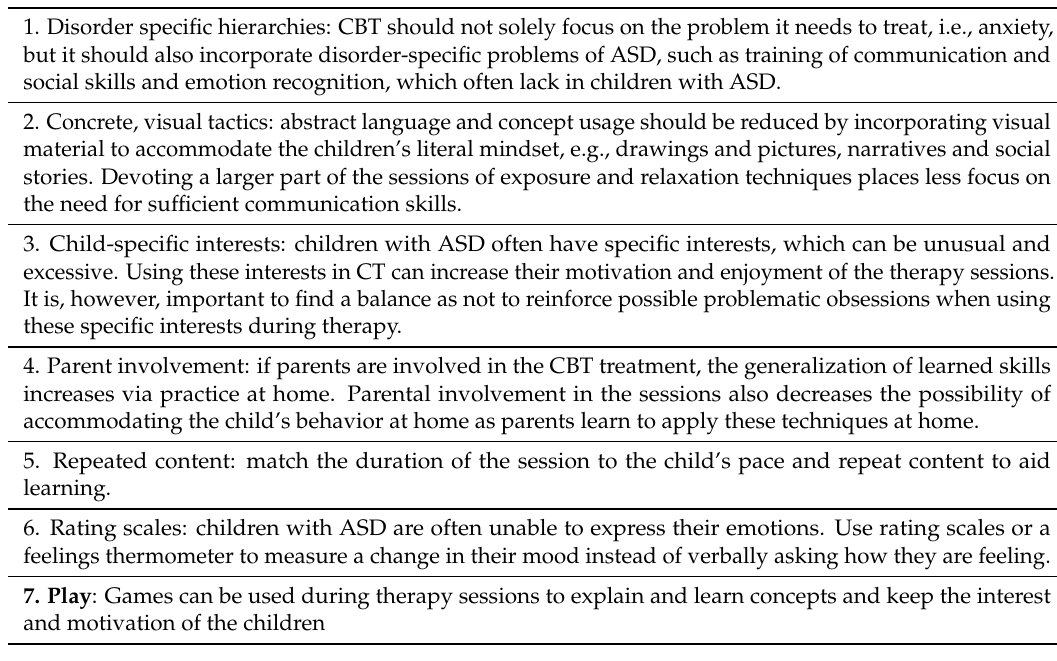
Table 1. Guidelines regarding the modification of Cognitive Behavioural Therapy (CBT) for Autism Spectrum Disorder (ASD) according to National Institute for Health and Care Excellence (NICE) [34] and literature reviews